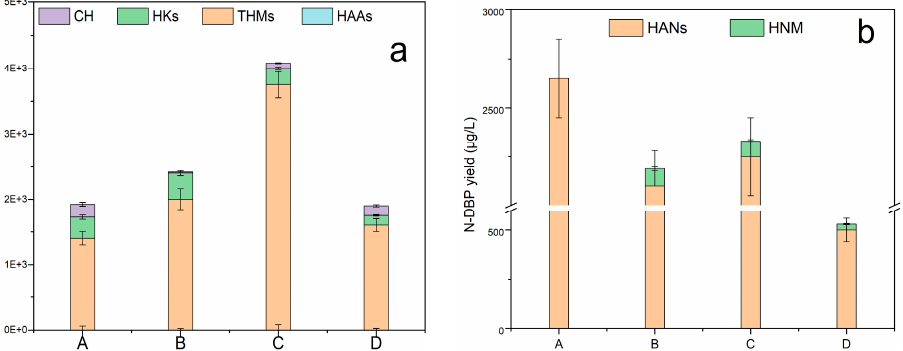
Figure 9. C-DBP and N-DBP yield of water samples ( a ) C-DBP yield; ( b ) N-DBP yield) (A: influent of wastewater, B: AGC effluent, C: AAO effluent, and D: MBR effluent). wastewater, B: AGC effluent, C: AAO effluent, and D: MBR